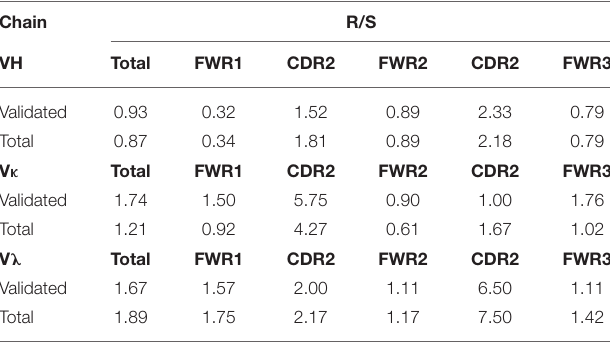
TABLE 3 | Summary of R/S ratios of variable region sequences from AAV memory B cells.